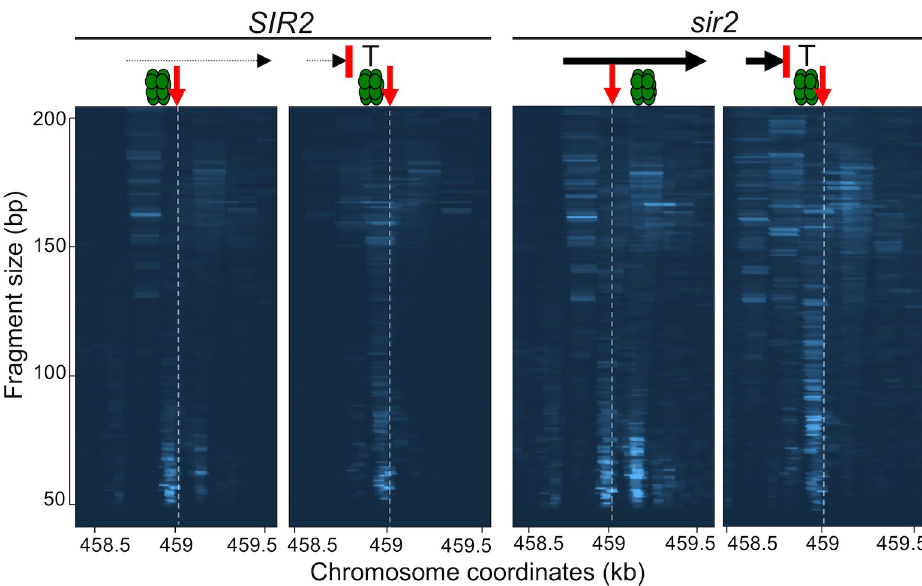
Fig 6. Terminator prevents displacement of Mcm2-7 (). G1-arrested SIR2 and sir2 strains with and without a CYC1 transcriptional terminator (red line marked with T) (strains 16855, 16895, 16905 and 16920 from left to right with 64, 85, 170 and 81 rDNA copies, respectively), inserted between the start of c-pro transcription and the rARS, as in Fig 1A, were analyzed for Mcm2-7 distribution by Mcm2-ChEC, as in Fig 4B. qPCR of the c-pro transcript distal to the terminator demonstrated reduced transcript level (Fig 5S). Genomic coordinates according to the sacCer3 genome are on the x axis, fragment size is on the y axis, and relative read depths are indicated by color intensity, green double hexamer is Mcm2-7. The vertical dotted line and the red vertical arrow indicate the position of the rARS (base pair 458,991 in sacCer3 genome sequence).